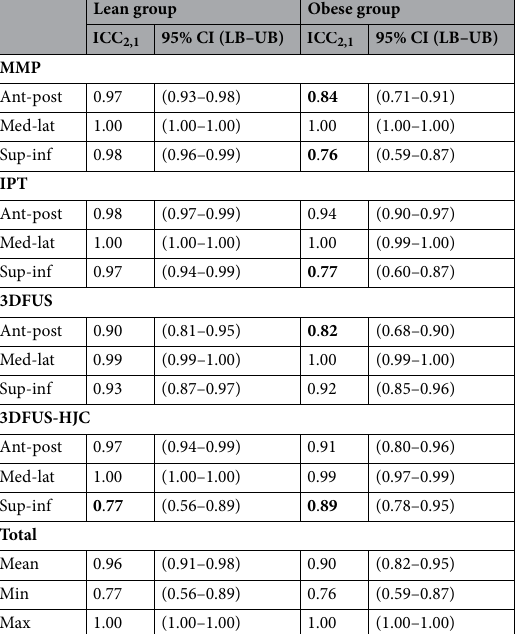
Table 2. The intraclass correlation coefficients ( ICC 2,1 ) and their 95% confidence intervals (CI) with lower and upper bounds (LB, UB) for manual marker placement (MMP), the instrumented pointer technique (IPT), and 3D free-hand ultrasound (3DFUS) to identify the anterior superior iliac spine (ASIS) as well the 3DFUS based hip joint center (HJC) estimation. ICCs were calculated between test and retest. Values lower than 0.9 were marked bold. Note that values are rounded to two decimal places which in cases of high ICCs renders values of